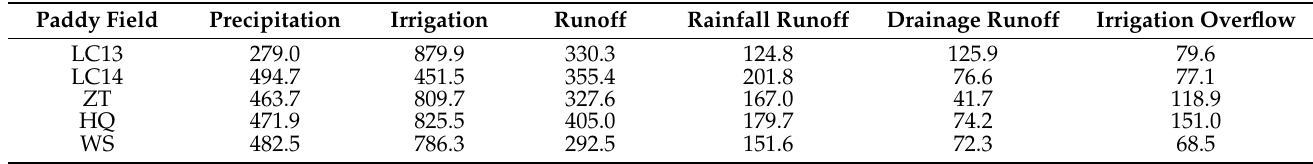
Table 1. Components of the hydrologic budget (mm) of the paddy